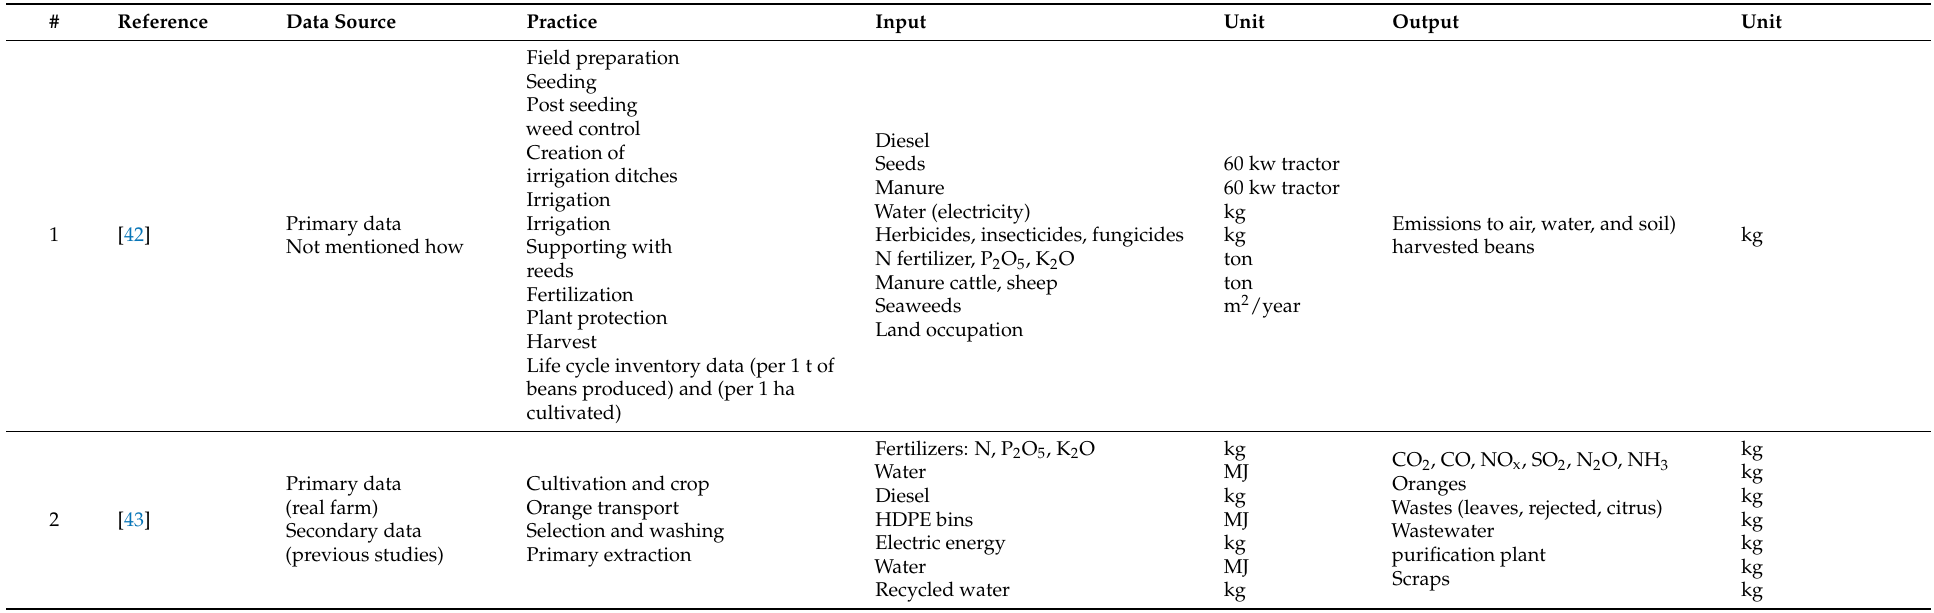
Table A2. Inventory data of the selected